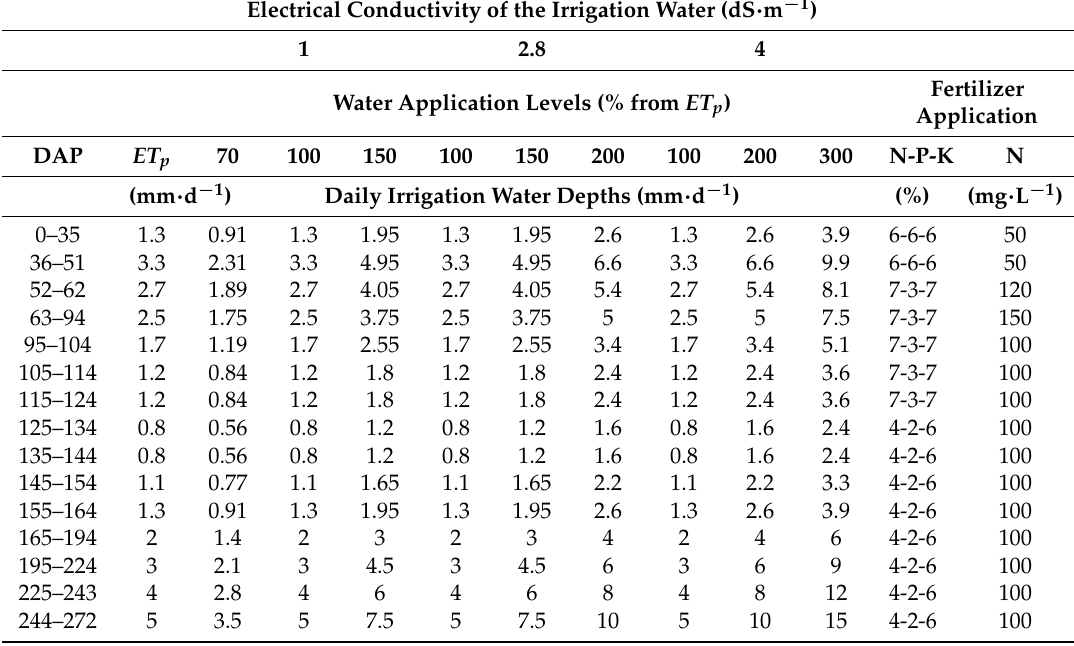
Table 1. Irrigation water salinities and their specific application levels, since Day After Planting (DAP). Fertilizer solution in irrigation water contained N as total nitrogen, P as P 2 O 5 and K as K 2